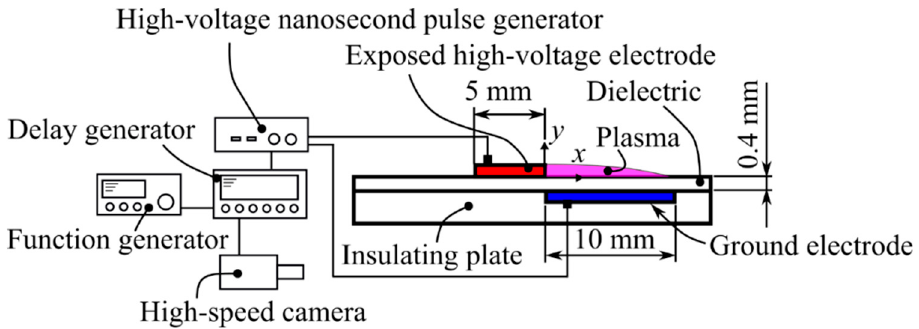
Figure 1. The ns-DBD plasma actuator with equipment for the control of the burst discharge.